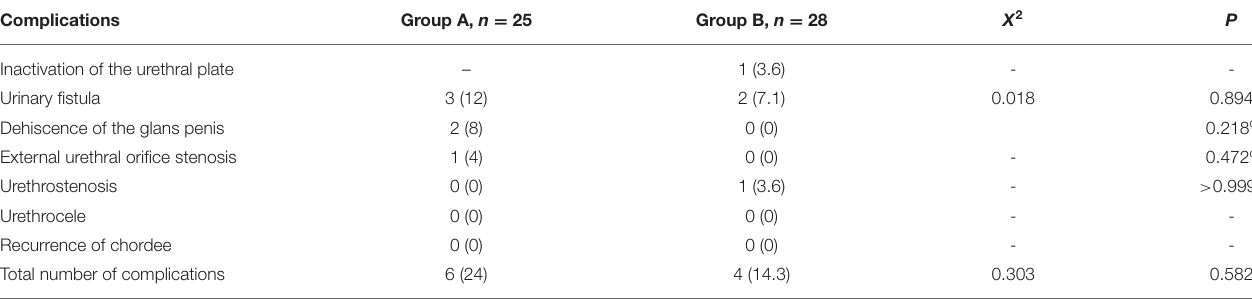
TABLE 3 | Postoperative complications between the two